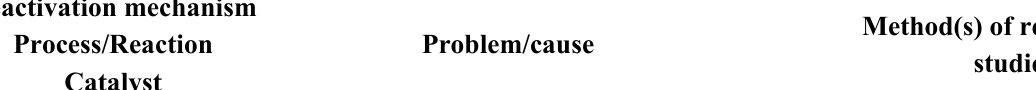
Table 20. Conventional Methods for and Representative Examples of Catalyst Regeneration from Scientific and Patent